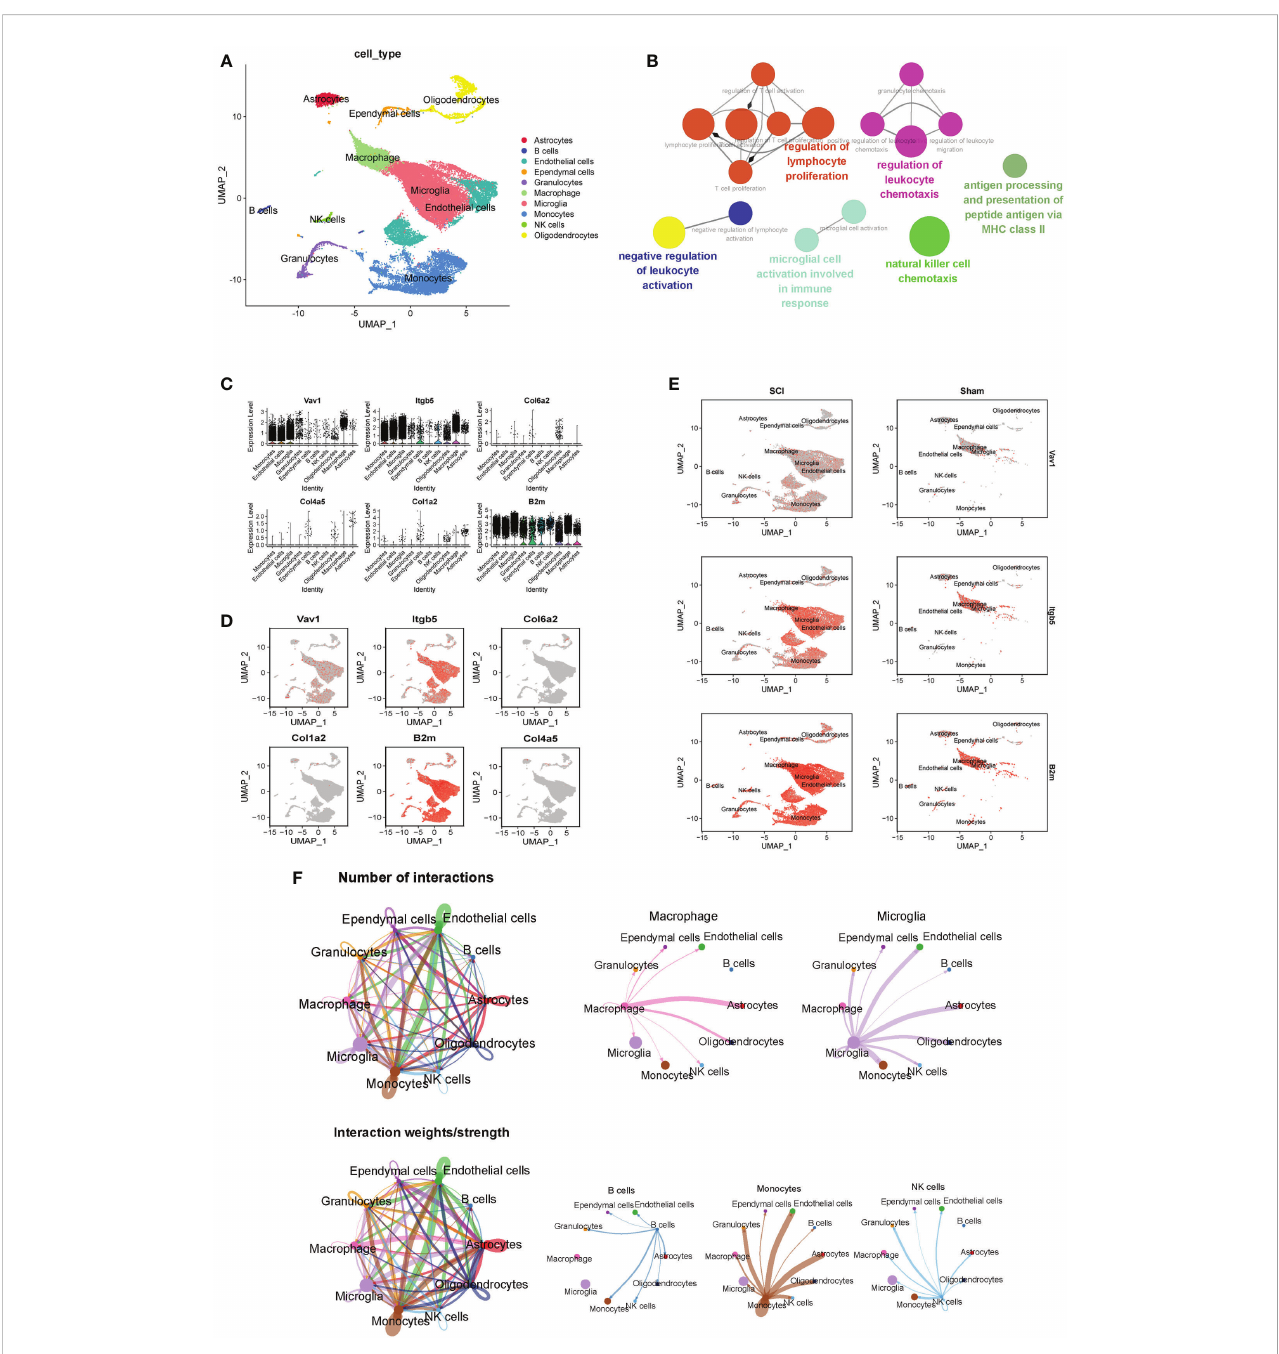
FIGURE 7 ScRNA-seq analysis of the subacute phase of spinal cord injury. (A) Nine cell clusters (astrocytes, B cells, endothelial cells, ependymal cells, granulocytes, microglia, monocytes, NK cells, oligodendrocytes) were identi fi ed on the UMAP plot. (B) The functional enrichment analysis of differentially expressed genes in different cell clusters. (C) The violin plots of six immune hub genes in each cluster. (D) The UMAP plots of six immune hub genes in each cluster. (E) Among these immune hub genes, Vav1 (Log FC=0.37), Itgb5 (Log FC=0.75), and B2m (Log FC=0.75) are characteristic genes of microglia/ macrophages. (F) The number and strength of interactions between 10 cell